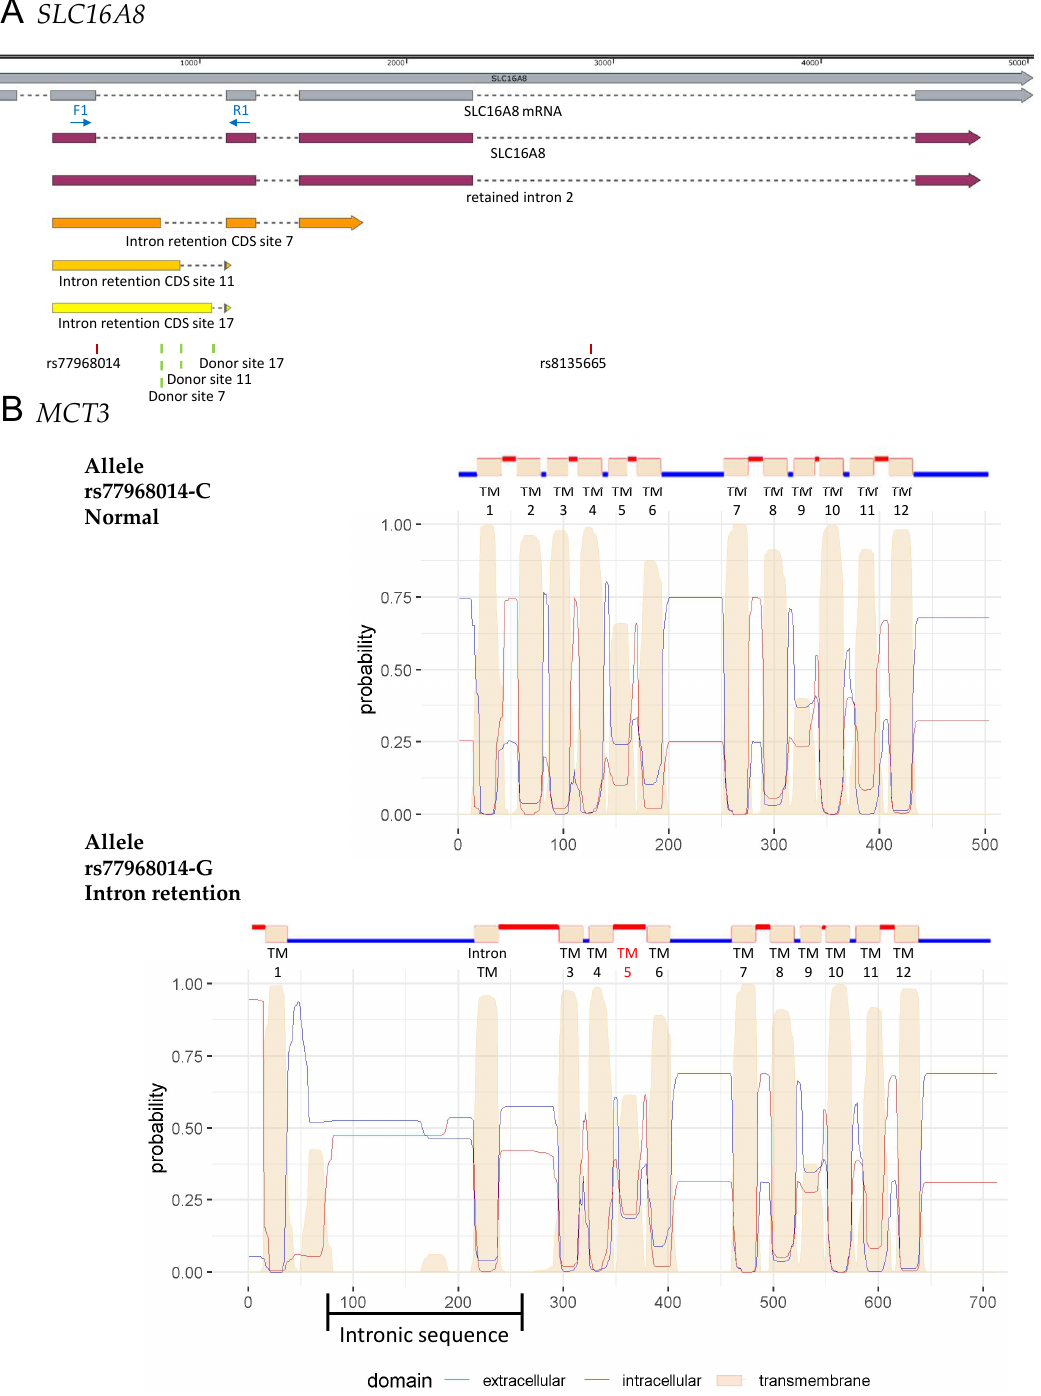
Figure 5. Bioinformatic analysis of potential cryptic donor sites for the allele rs77968014-G. ( A ) We introduced the rs77968014 SNP in the sequence of the human SLC16A8 gene and analyzed the potential donor sites that could be revealed with the Human Splicing Finder 3.1. We found 3 sites above the threshold (donor site 3, 11 and 17) among the 20 potential donor sites. We used SnapGene ® software (from GSL Biotech; available at snapgene.com) to visualize the 3 sites and the resulting coding sequences (CDS). ( B ) Prediction of transmembrane helices in proteins with TMHMM (http://www.cbs.dtu.dk/services/TMHMM/) to study the predicted